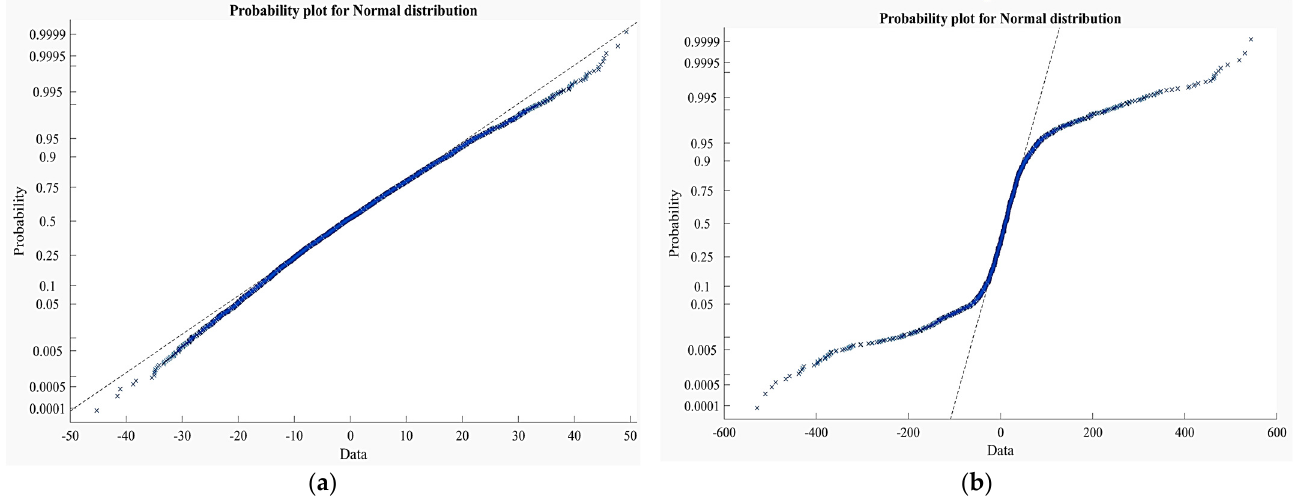
Figure 15. The probability plot for ( a ) bearing vibration signal with the normal condition and ( b ) bearing vibration signal with inner race fault.